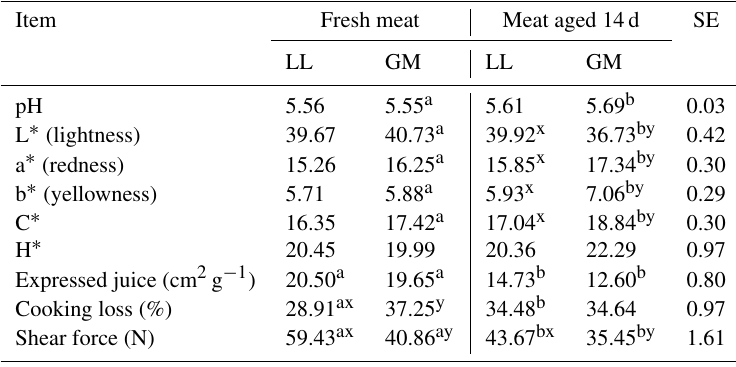
Table 2. The mean values for meat quality properties for different muscles and aging time. Item Fresh meat Meat aged 14d SE LL GM LL GM